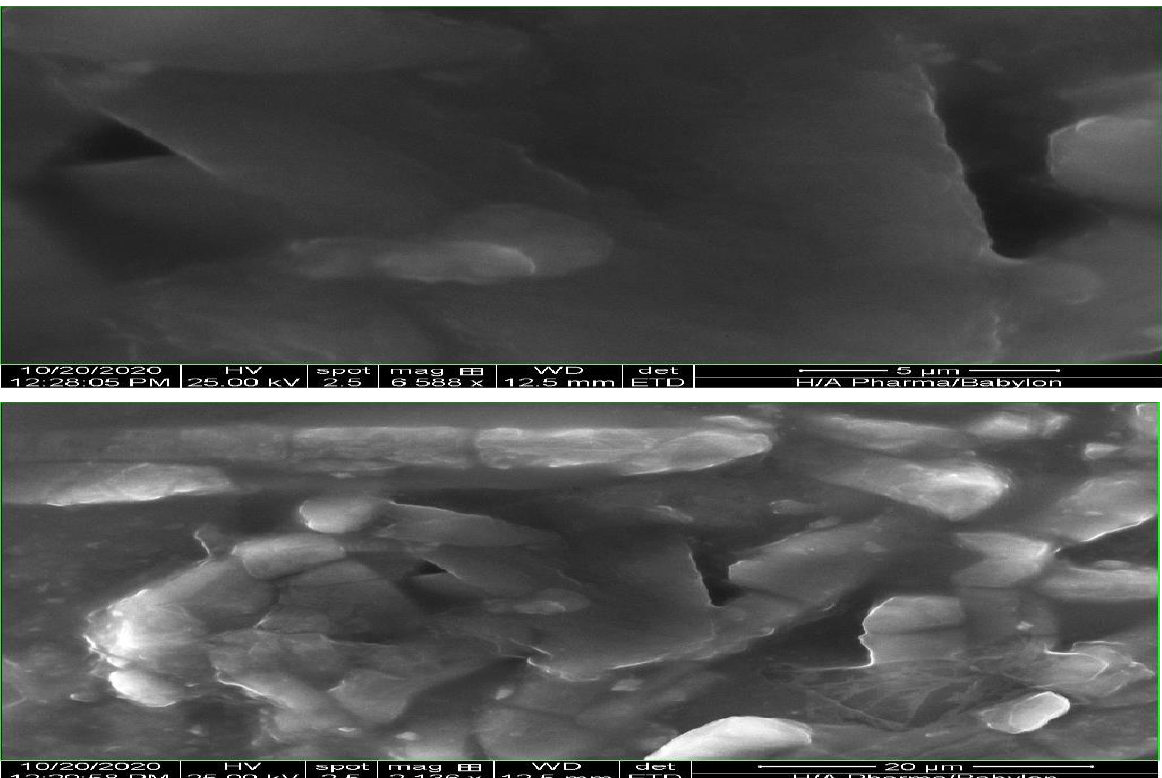
Figure 2. Scanning electron microscopic photographs of